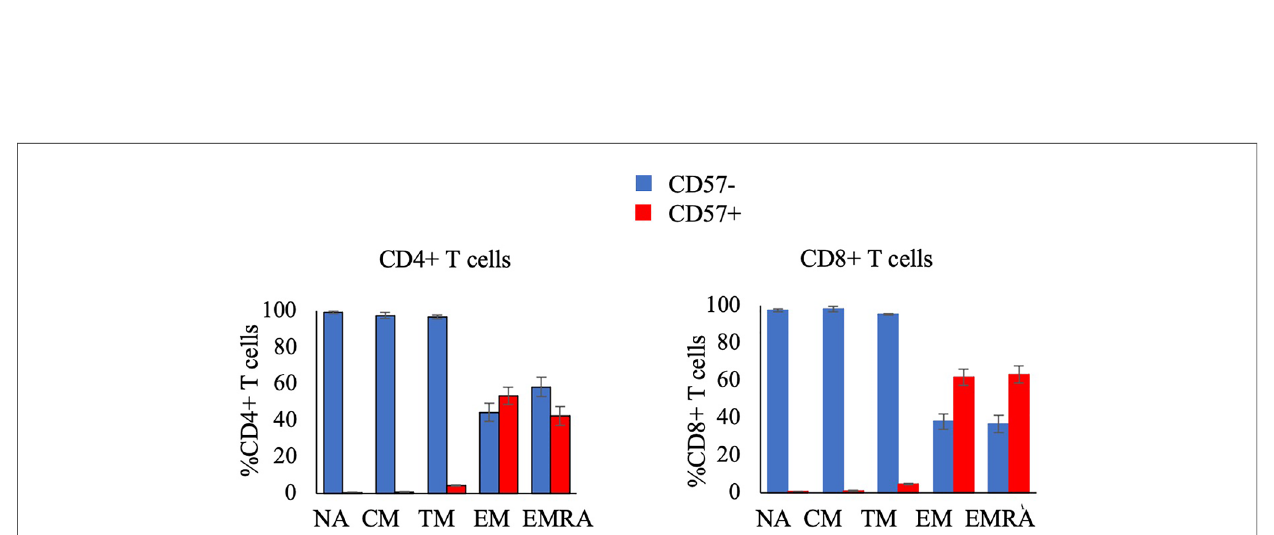
FIGURE 3 The proportion of CD4+ T-cell subsets (left panel) and CD8+ T-cell subsets (right panel) that are CD57- or CD57+in resting blood. Data are displayed as mean and standard error (error